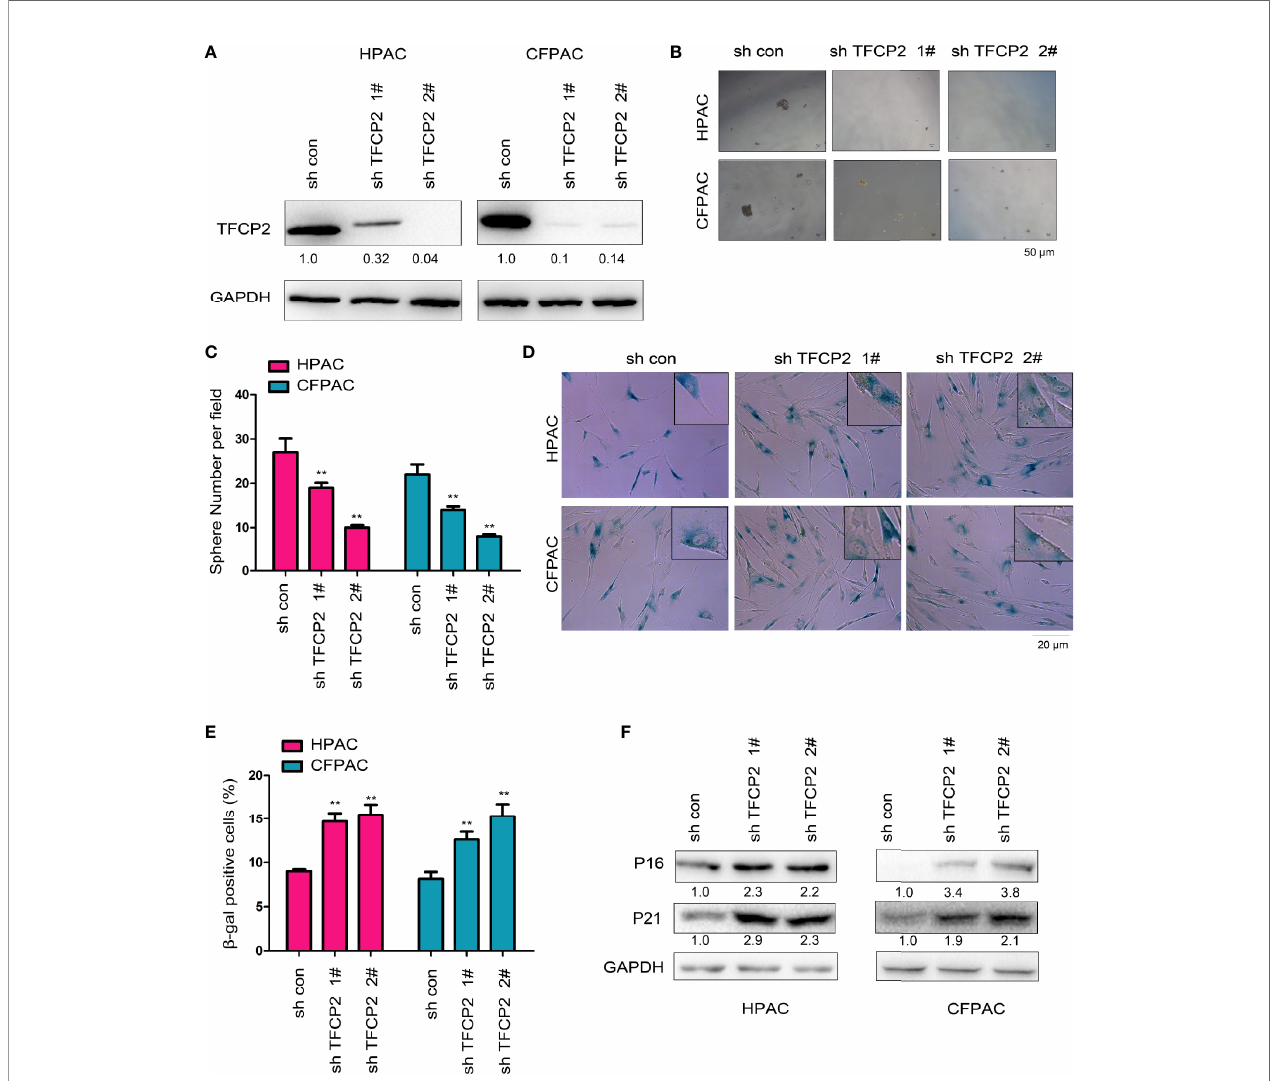
FIGURE 3 | TFCP2 promoted the senescence of pancreatic cancer cells. (A) The pancreatic cells were infected with the lentivirus for the knockdown of TFCP2. Cells were selected with puromycin and the resistant cells were pooled. The expression of TFCP2 were examined using western blot. (B, C) Sphere formation assay was performed to evaluate the effects of TFCP2 knockdown on the cell growth, and the statistical analysis was performed. (D, E) b -Gal staining was performed to evaluate the effects of TFCP2 knockdown on the senescence, and the statistical analysis was performed. (F) The protein levels of senescence modulators were examined using western blot. The fold change was indicated. ** P <